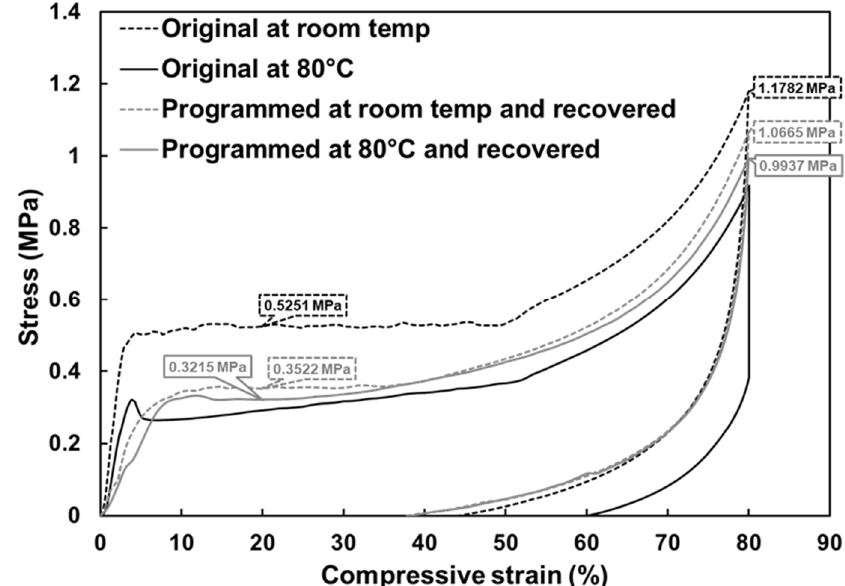
Figure 14. Comparison of stress and strain relationships under uniaxial compression to 80% strain between original samples at room temperature and 80 ◦ C, and shape-recovered samples with ε m of 80% at room temperature.